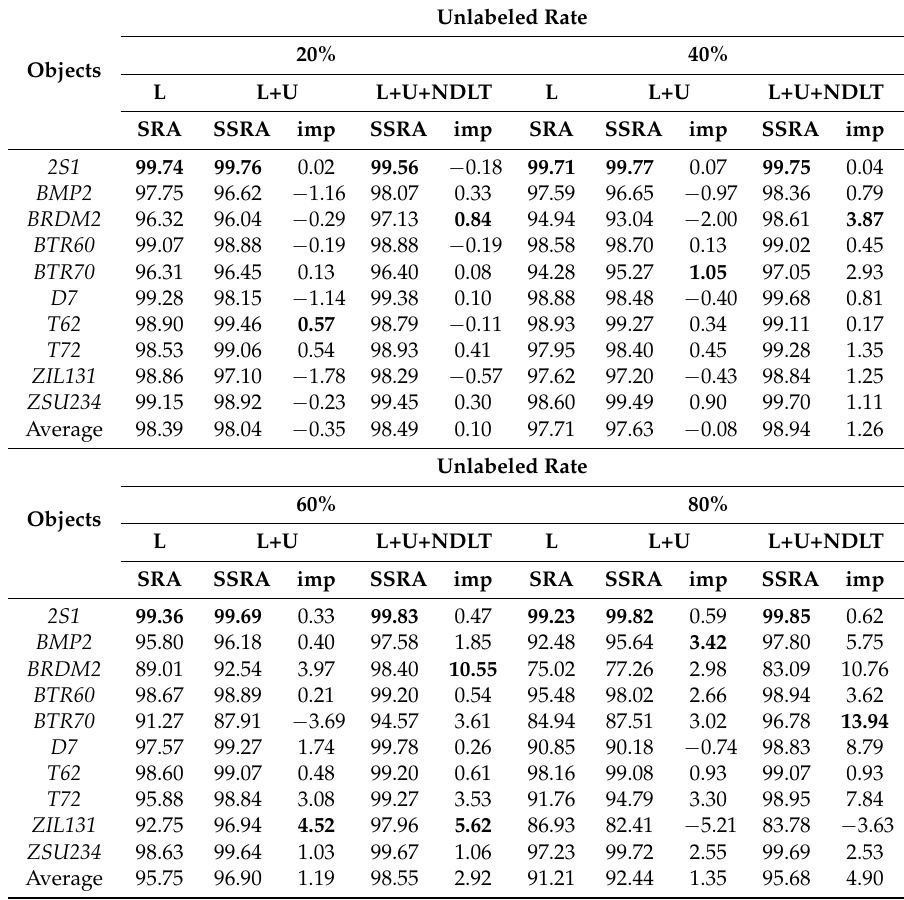
Table 3. Recognition accuracy (%) and relative improvements (%) of our semi-supervised learning method under different unlabeled rates. The best accuracies are indicated in bold in each column. Unlabeled Rate 20% Objects